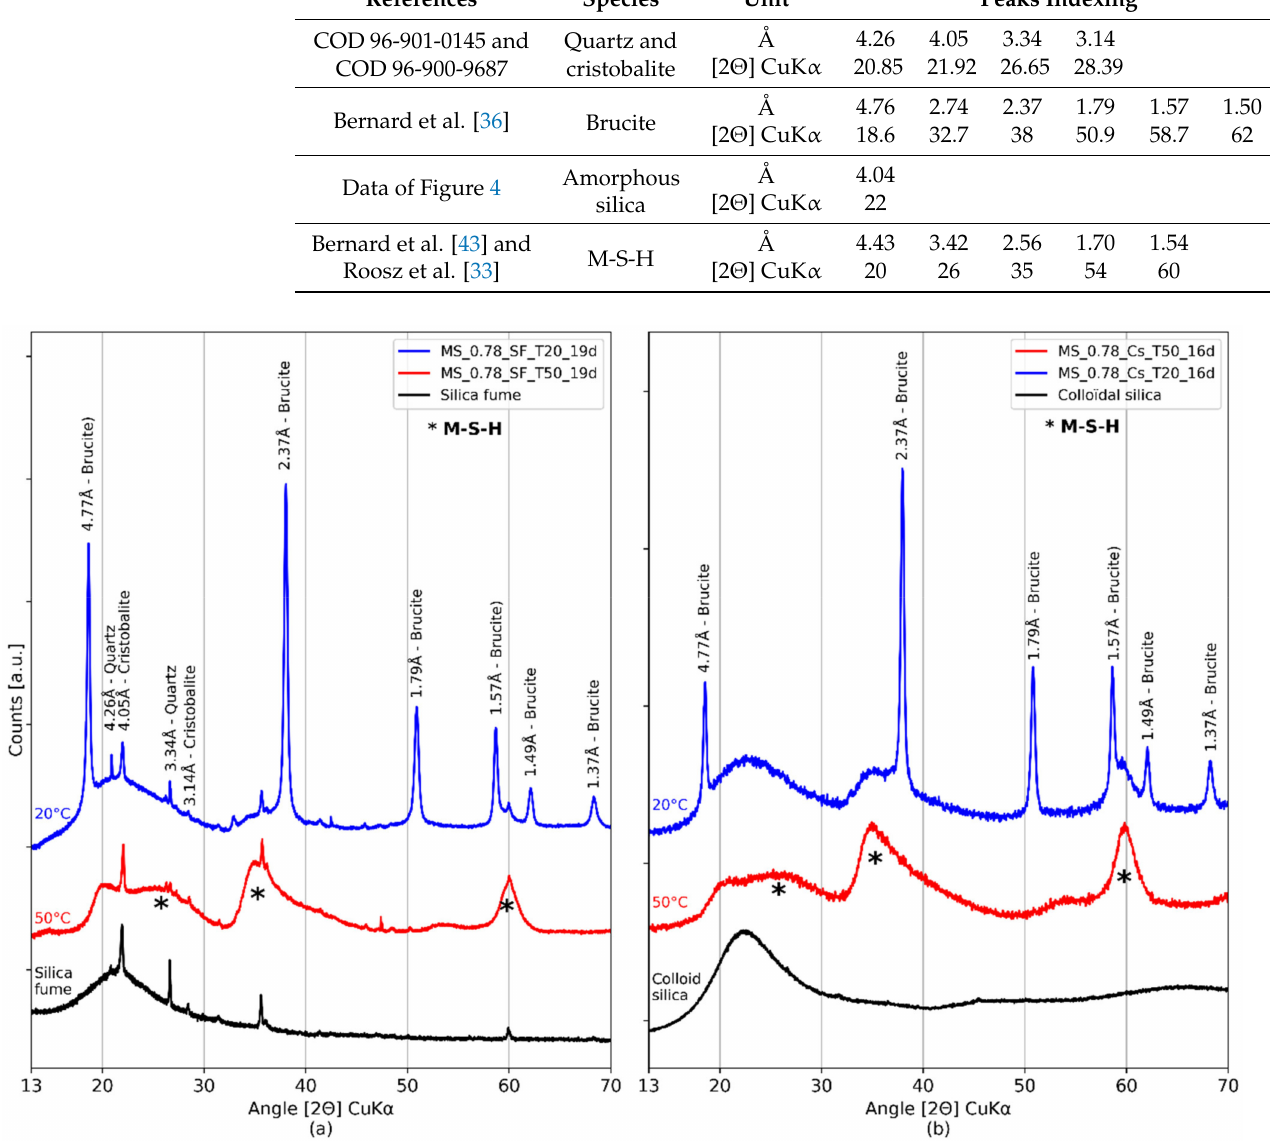
Figure 6. X-ray diffractograms of M-S-H pastes with M/S = 0.78. Comparison between the four protocols after two weeks of hydration. ( a ) Pastes with silica fume and M/S = 0.78 after 19 days of hydration at 20 ◦ C (blue) or 50 ◦ C (red) ( b ) Pastes with colloidal silica and M/S = 0.78 after 16 days of hydration at 20 ◦ C (blue) or 50 ◦ C